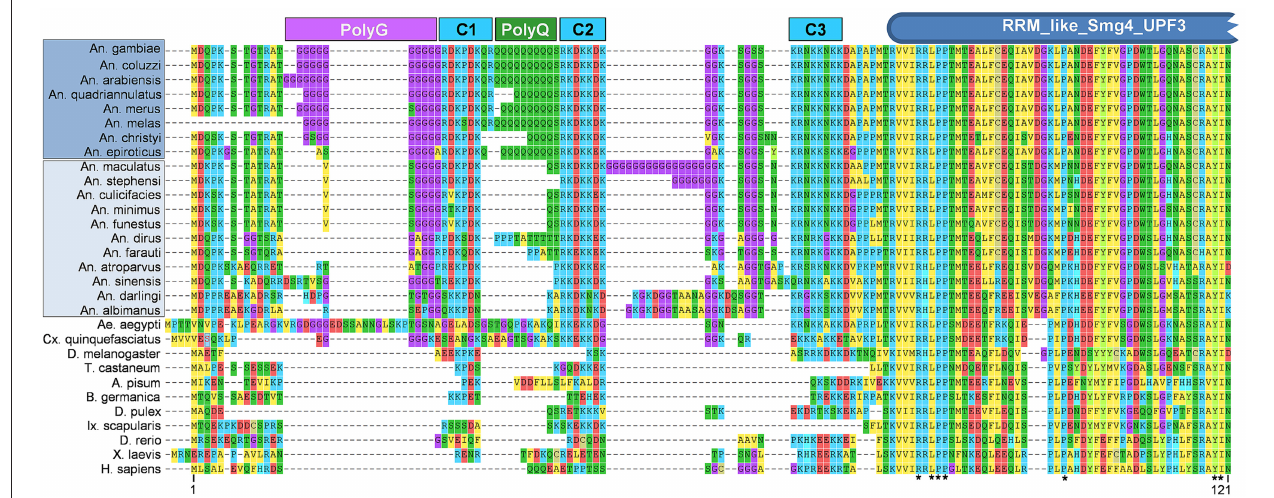
FIGURE 1 | Alignment of N-terminal region of CSPBP/UPF3 across Metazoan taxa. Predicted amino acid sequences of CSPBP/UPF3 from eight species of Anopheles ( An .) mosquitoes within Series Pyretophorus (Dark blue highlight), along with 11 other Anopheline species (light blue highlight), Culicine mosquitoes Aedes (Ae.) aegypti, and Culex (Cx.) quinquefasciatus , vinegar fly [ Drosophila (D.) melanogaster ], red flour beetle [ Tribolium (T.) castaneum ], pea aphid [ Acyrthosiphon ( A.) pisum ], German cockroach [ Blatella (B.) germanica ], water flea [ Daphia (D.) pulex ], lyme disease tick [ Ixodes (Ix.) scapularis ], zebrafish [ Danio (D.) rerio ], African clawed frog [ Xenopus (X.) laevis ], and Homo (H.) sapiens . Protein sequences were aligned using MUSCLE (default parameters) as implemented by MEGA7.0 ( Kumar et al., 2016); only the first 121 amino acids ( An. gambiae ) CSPBP/UPF3 are shown. Polyglycine (PolyG), polyglutamine (PolyQ), and charged (C1, C2, C3) regions are indicated, as is the RRM_like_Smg4_UPF3 domain predicted by NCBI Conserved Domain Search ( Marchler-Bauer et al., 2015). *Indicates residues identical in all taxa. Protein sequences were obtained from Vectorbase [AGAP006649-PA, ACOM039391-PA, AARA008524-PA, AQUA004756-PA, AMEM012101-PA, AMEC019700-PA, ACHR004711-PA, AEPI005003-PA, AMAM019987-PA, ASTE011169-PA, ACUA004840-PA, AMIN007750-PA, AFUN004273-PA, ADIR007334-PA, AFAF009144-PA, AATE016492-PA, ASIS017649-PA, ADAC007751-PA, AALB004502-PA, AAEL003735-PA] or NCBI [XP_001847099.1,